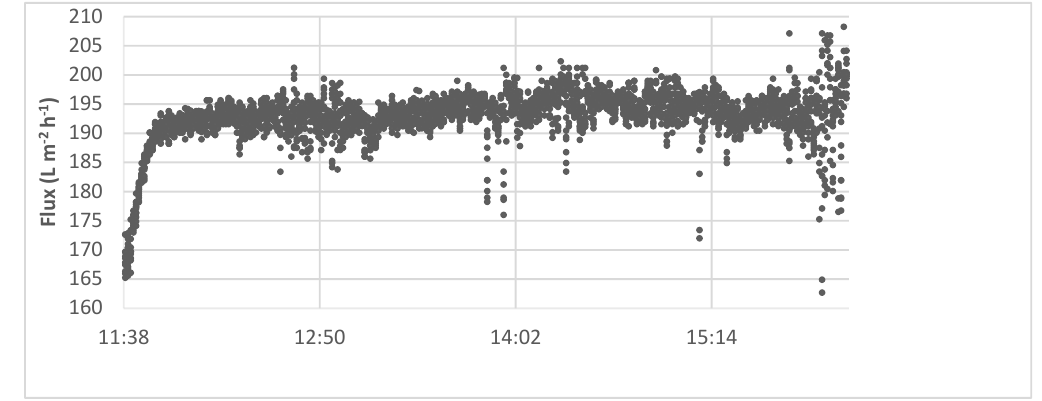
Figure 5. Membrane performance of the softening with calcium hydroxide.